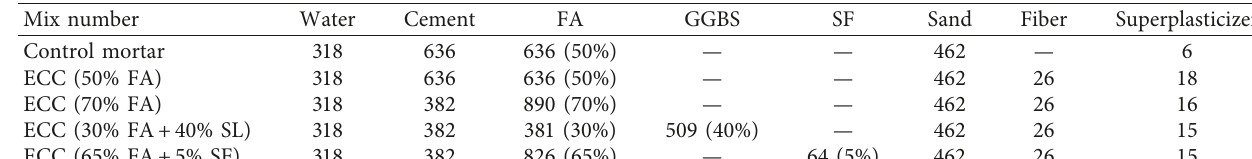
Table 2: Mix proportion and properties of ECC (kg/m 3 ).